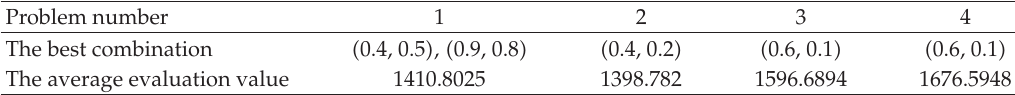
Table 6: The best combination of (cid:6) P c ,P m (cid:7)